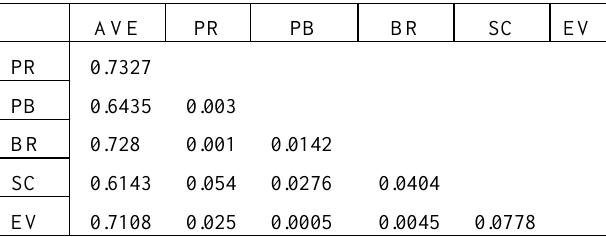
Table 3: Average variance extracted and squared interconstruct correlation estimates